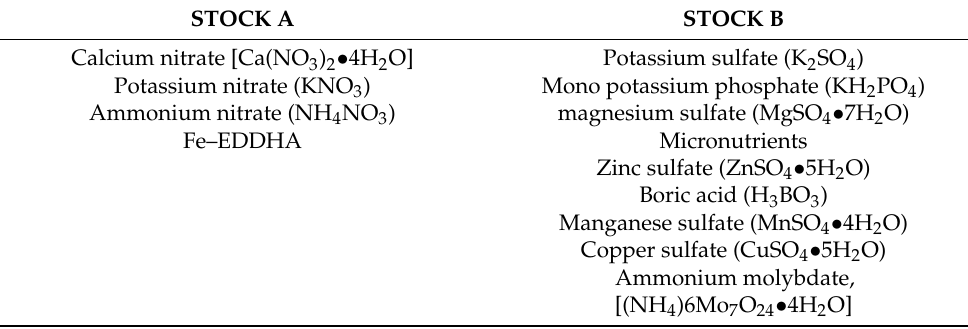
Table 1. Elemental content and formulations of plant nutrients in stocks used as a reagent.